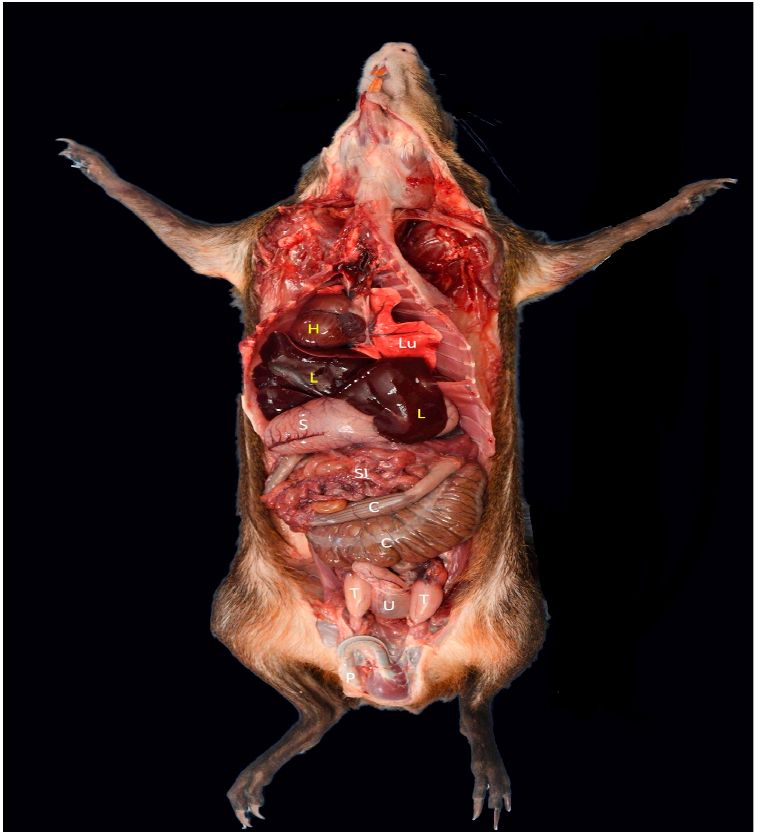
Figure 2. Photograph showing the anatomical view of visceral organs in situ of an adult male D. leporina . H—heart; L—liver; Lu—lungs; S—stomach; SI—small intestine; C—colon; T—testis; U—urinary bladder; P—penis.